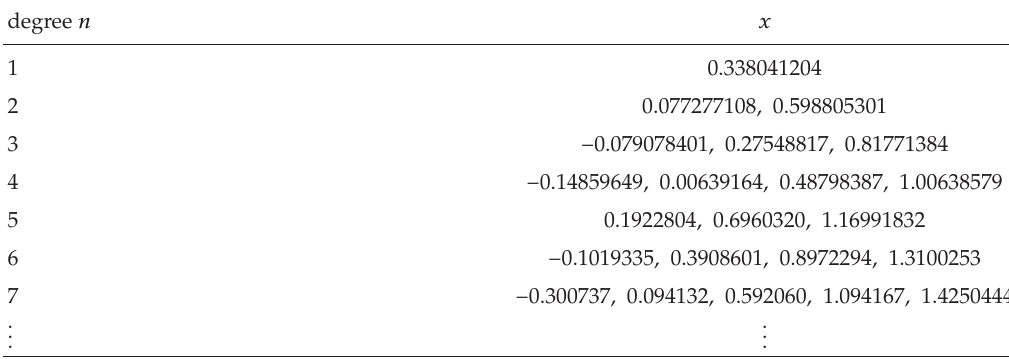
(cid:2) 3 (cid:3) (cid:2) x (cid:3) (cid:6) 0 , q (cid:6) 1 / 2 , x ∈ R n,q